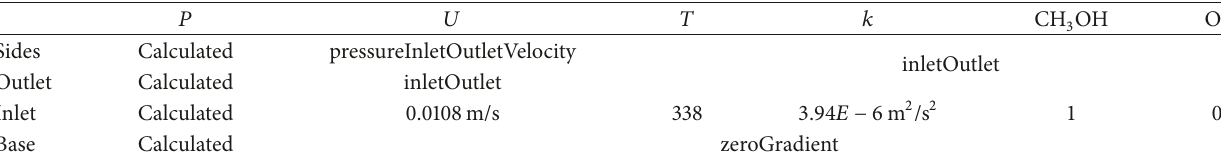
Table 2: Boundary conditions.